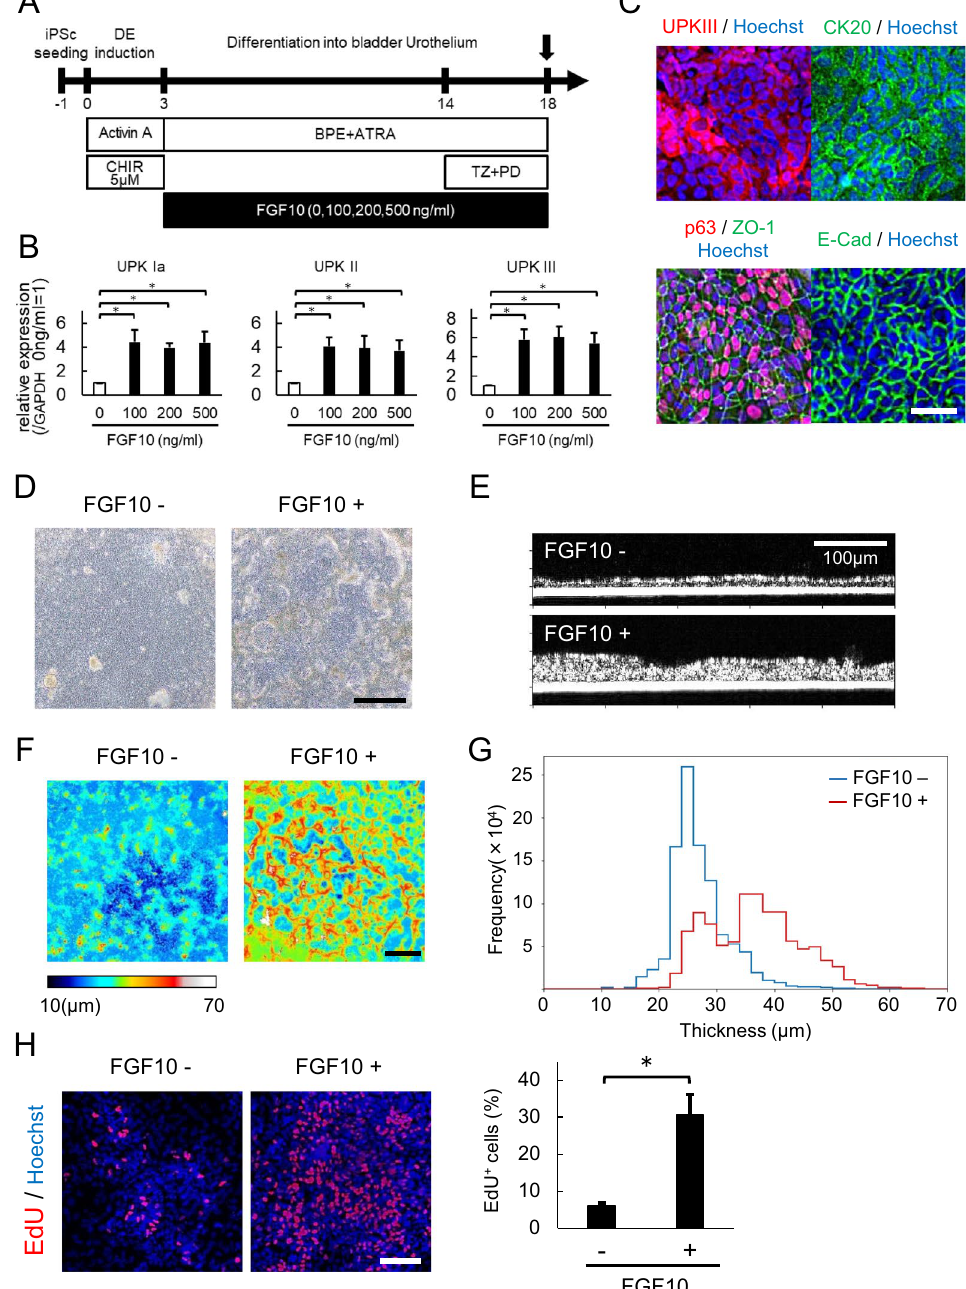
Figure 5. FGF10 enhanced urothelial differentiation and stratification. ( A ) After posterior DE induction, cells were treated with 0, 100, 200, or 500 ng/ml FGF10 from days 3 to 18. ( B ) A quantitative RT-PCR analysis of urothelial markers (UPK Ia, UPK II, and UPK III) in differentiated cells at day 18 after treatment with the indicated concentrations of FGF10. Data are shown as the mean ± SEM (n = 6 independent experiments). * p < 0.05; Dunnett’s test. ( C ) Immunostaining of UPK III, CK20, p63, ZO-1 and E-Cadherin in differentiated cells. Scale bar, 50 µ m. ( D ) Phase contrast images of differentiated cells with (right panel) or without (left panel) FGF10 treatment (100 ng/ml). ( E ) Optical coherence tomography (OCT) images of differentiated cells treated with (lower panel) or without (upper panel) FGF10 in high-resolution mode. ( F ) The thicknesses of the differentiated cells with (right panel) or without (left panel) FGF10 treatment were visualized using a color-scale heatmap from 10 to 70 μ m in low-resolution mode. Scale bar, 1 mm. ( G ) A histogram of the OCT analysis of differentiated cells with (red line) or without (blue line) FGF10 treatment in low-resolution mode. ( H ) An EdU assay for the cells with and without FGF10 treatment. Representative fluorescence microscopic images of EdU (left panel) and the proportions of EdU-positive cells (right panel) are shown (n = 5 different fields; mean ± SD). * p < 0.05; two-tailed paired t -test. Abbreviations: iPSc, induced pluripotent stem cell; DE, definitive endoderm; CHIR, CHIR99021; BPE, bovine pituitary extract; ATRA, all-trans retinoic acid; TZ, troglitazone; PD, PD153035; UPK,